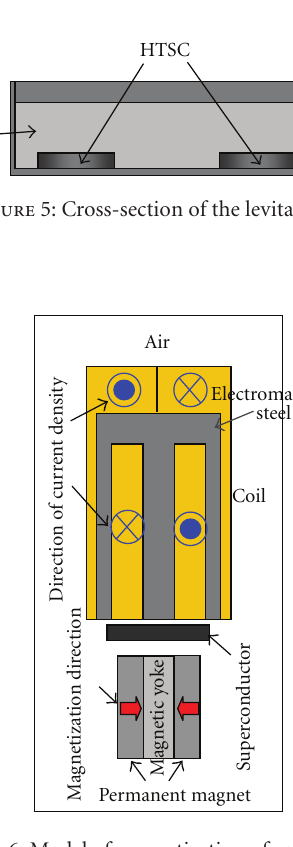
Figure 6: Model of magnetization of opposite